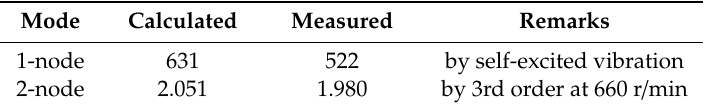
Table 1. Calculated and measured natural frequencies in cycles per minute.